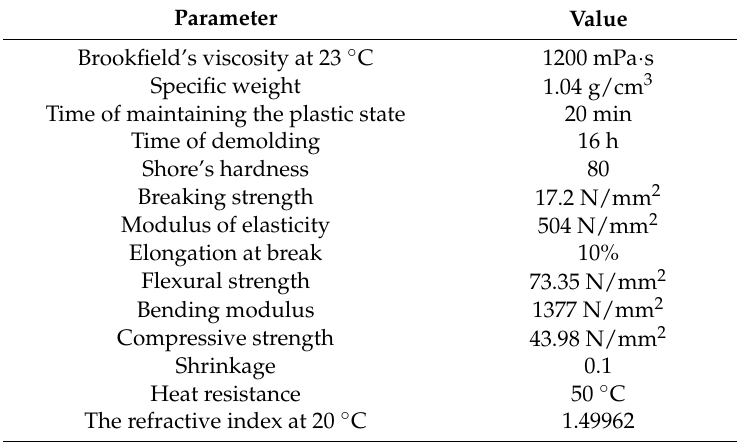
Table 1. Properties of the Crystal Clear Synolite Resin (information from the product’s